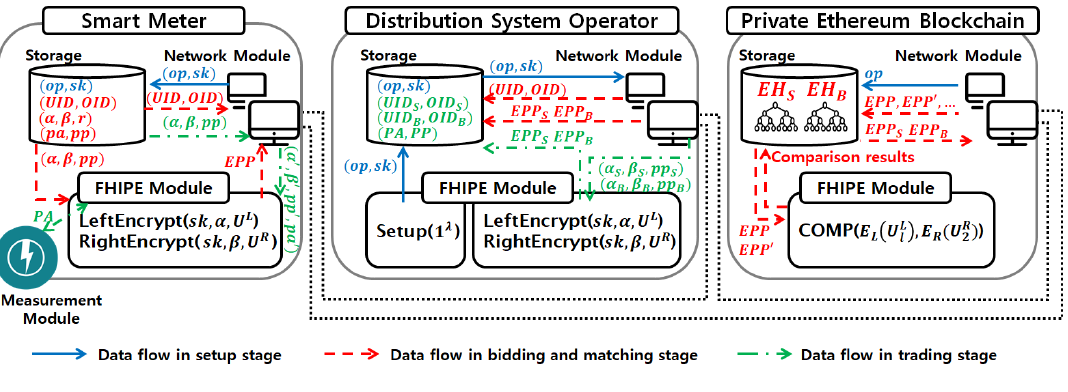
Figure 5. Components of the proposed system. FHIPE = function-hiding inner product